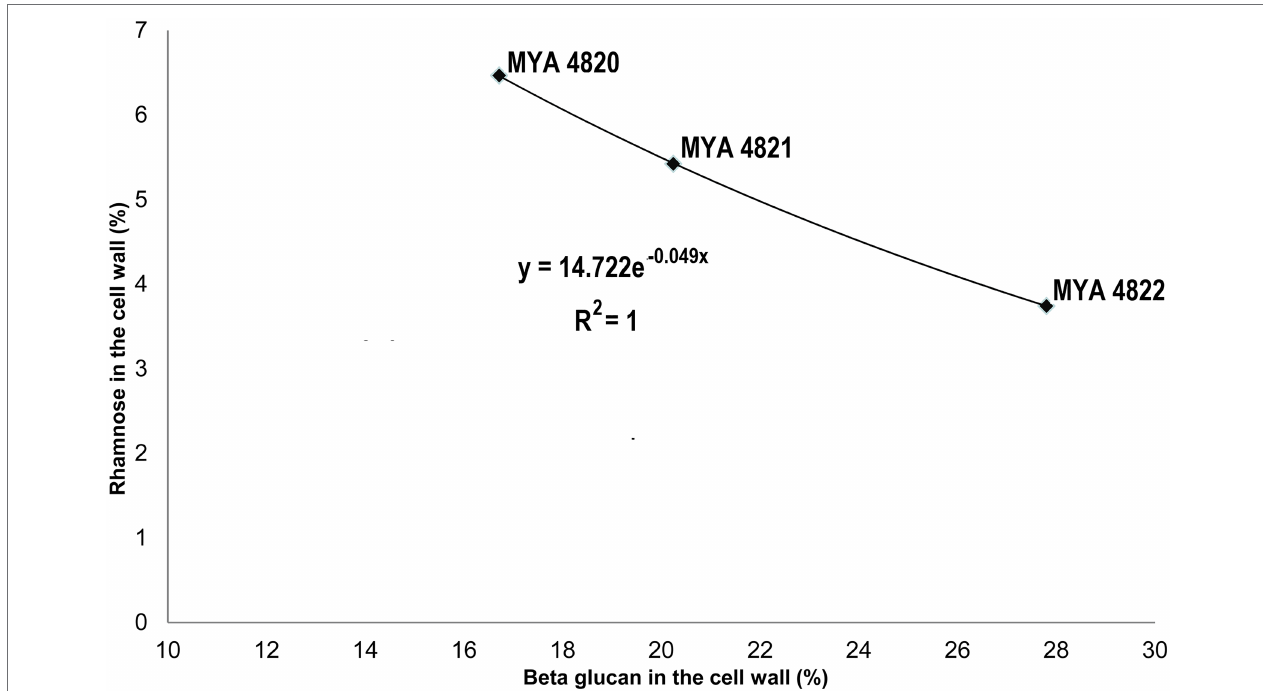
FIGURE 7 | A mathematical model for the Rhamnose/ β -glucan composition as expression of virulence. With an increase in reported virulence, the rhamnose proportion rise and β -glucan decreases. This observation fit to an exponential curve with an R 2 = 1, that could be expressed as a linear equation: ρ = − 0.049( β ) + 2.7, where β represents the β -glucan composition and ρ = Ln(Rha), where Rha is the rhamnose cell wall percentage. This model might be useful to predict the virulence level employing the β -glucan and rhamnose percentage ratio. This mathematical expression infers the highest rhamnose percentage to 15% ( β = 0) and for the lowest rhamnose percentage (1%) β =